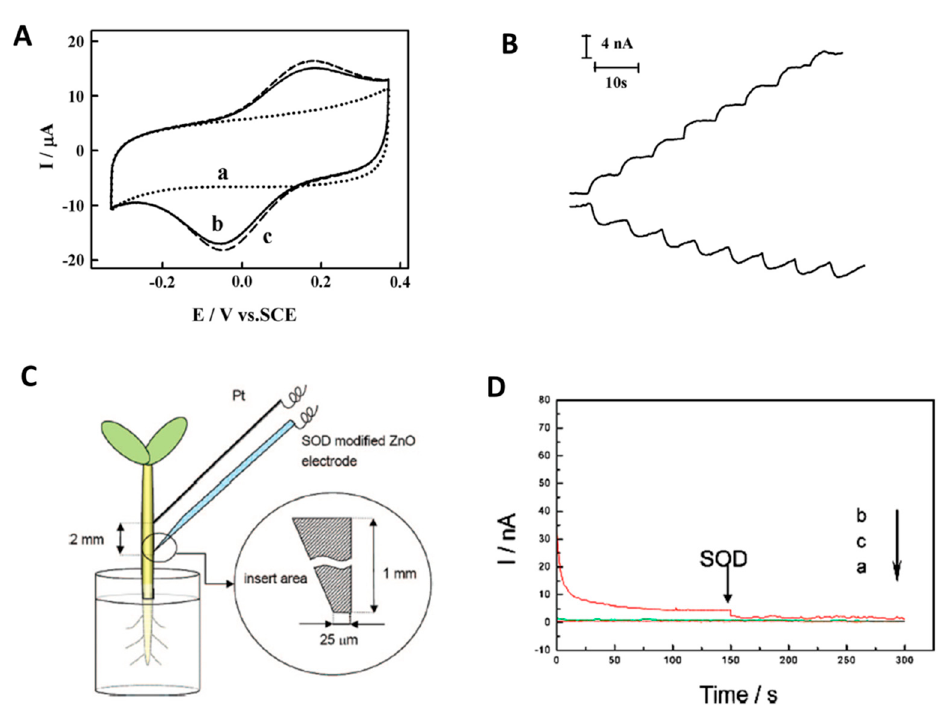
Figure 9. ( A ): CVs recorded with the cys/DenAu/GC electrode in the presence of 100 µ M O 2 •− (a) and with the SOD/cys/DenAu/GC electrode in the absence (b) and presence (c) of 100 µ M O 2 •− in 25 mM PBS, pH 7.2. ( B ): Amperometric responses of the SOD/cys/DenAu/GC biosensor to successive addition of 0.1 µ M O 2 •− at +0.3 V and − 0.2 V in 25 mM PBS pH 7.2. ( C ): Schematic representation of the setup for the determination of O 2 •− in bean sprouts with a SOD biosensor. ( D ): Amperometric responses of the SOD/ZnO biosensor (a, b) and ZnO microelectrode at 0.5 vs. Pt in a bean sprout grown under normal atmosphere (a) and in hypoxic conditions (b,c). Reproduced from [172] ( A , B ) and [132] ( C , D ) by